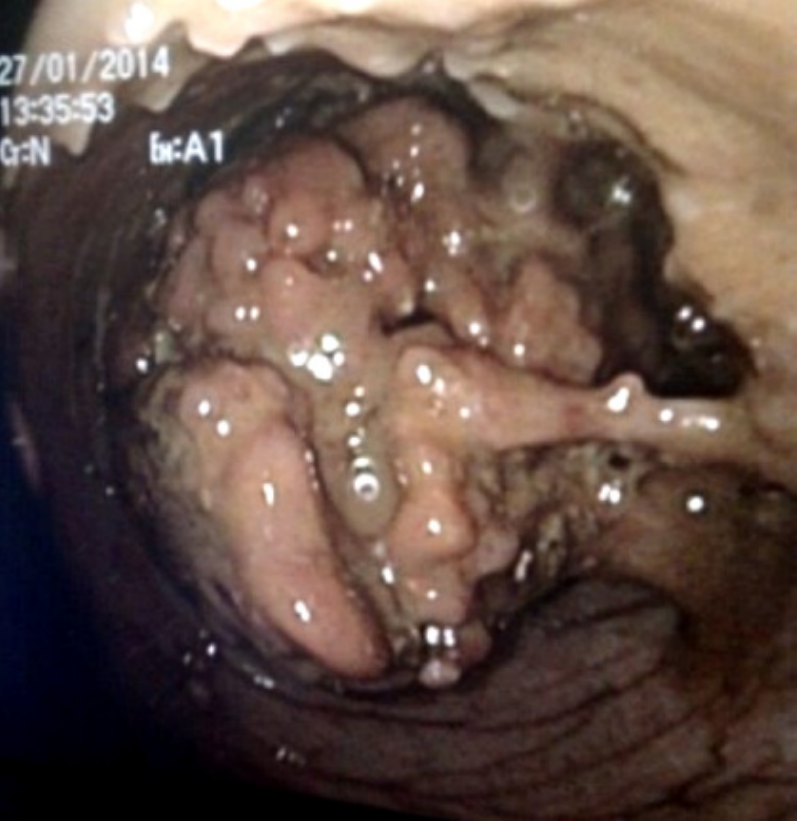
Figure 3. Endoscopic view of conglomerate of giant inflammatory polyps on the splenic flexure of the colon.